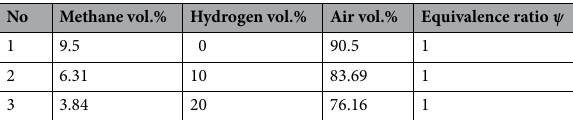
Table 2. Compositions of hydrogen-methane-air mixtures.